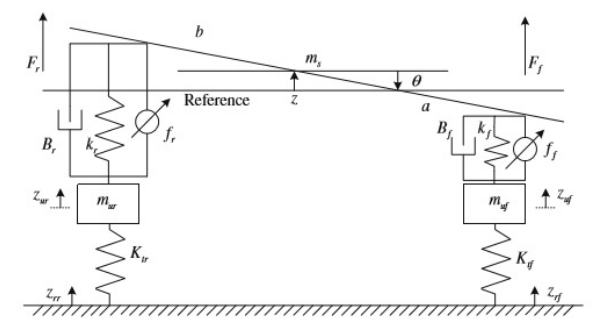
Figure 2. Half car model of ASS [8].